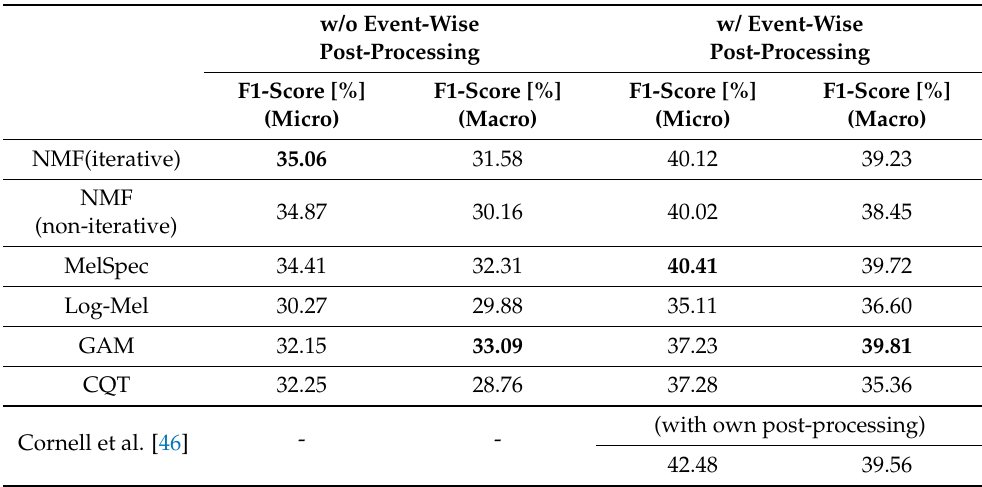
Table 1. Averaged results of various features. The performance of the Cornell system was provided as a reference of comparison. The boldface means the best performance of each